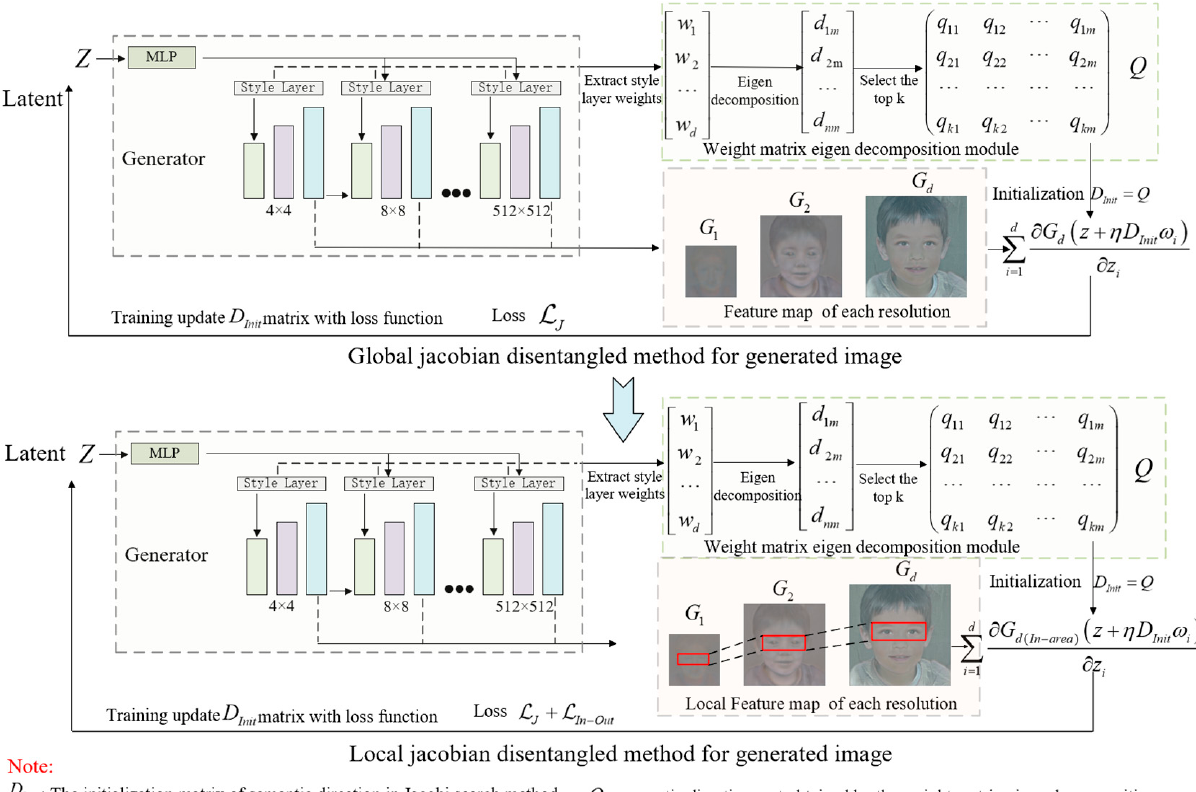
Figure 3. The overall architecture of our proposed generated image editing method.